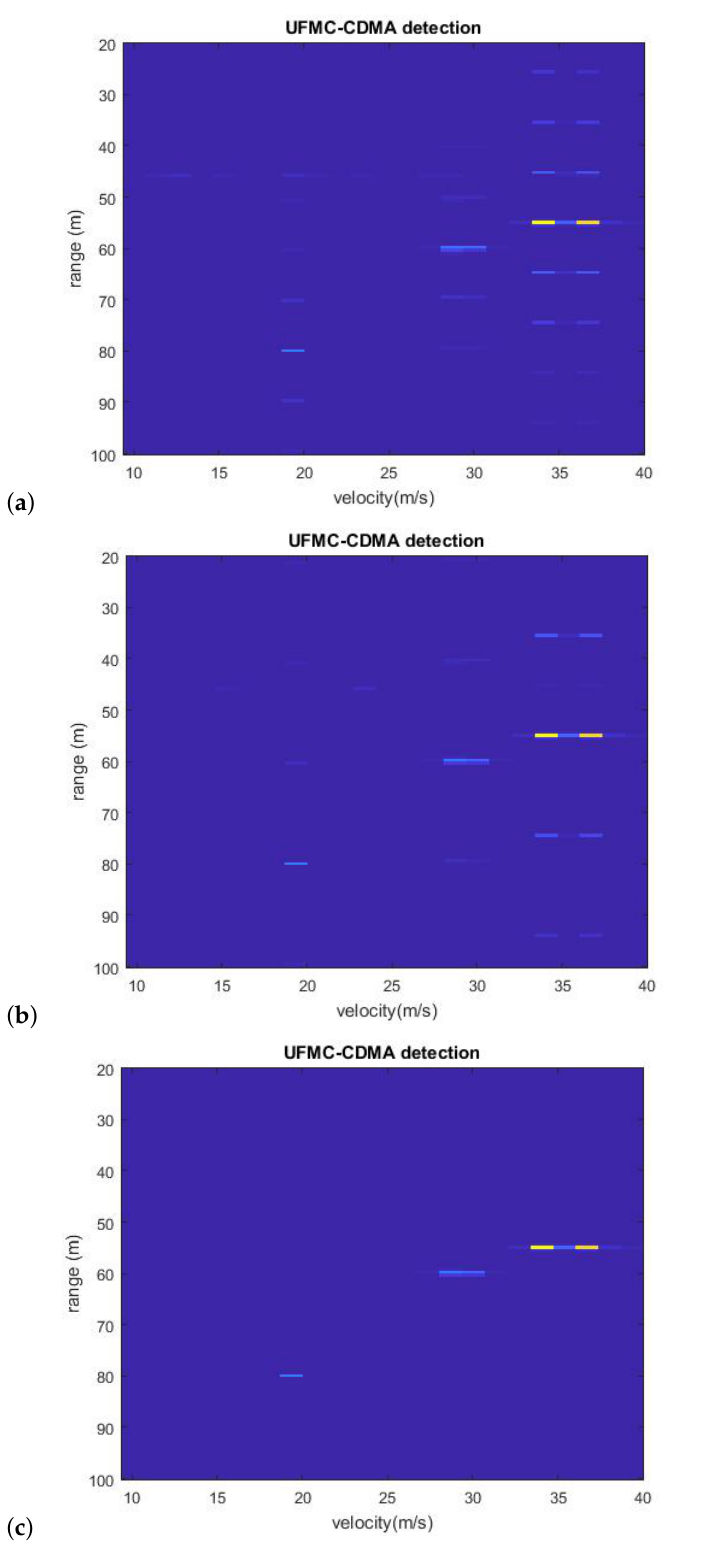
Figure 7. UFMC-code division multiple access (CDMA) radar performance with different spreading codes: ( a ) nonscrambled, ( b ) low-scrambled, and ( c ) high-scrambled